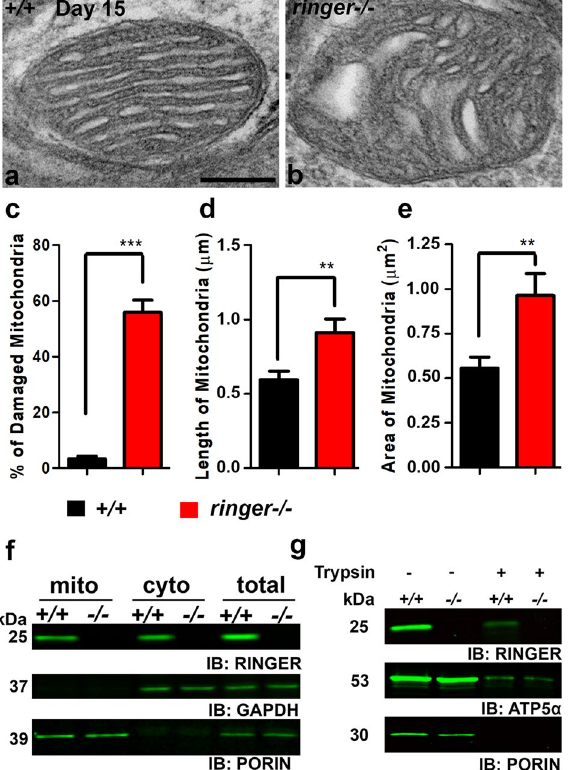
Figure 3. Ringer mutants show mitochondrial ultrastructural deficits and Ringer is detected in subcellular mitochondrial fractions. ( a , b ) Electron micrograph of mitochondria from day 15 flies shows enlarged mitochondria with disrupted cristae morphology in ringer −/− ( b ) compared to wild type ( a ). ( c - e ) Quantification of percentage of damaged mitochondria ( c ), mitochondrial length ( d ) and mitochondrial area ( e ) from ultrastructural analyses of wild type (black) and ringer −/− (red) mitochondria from mushroom body region of the adult brains. n = 6 brains per genotype. Statistics was done using unpaired student’s t test. ( c ) *** p < 0.0001, ( d ) ** p = 0.0079, ( e ) ** p = 0.0063. ( f ) Immunoblots of subcellular fractionation from wild type and ringer −/− fly heads probed for anti-Ringer, anti-Porin and anti-GAPDH in the mitochondrial (mito) and cytoplasmic (cyto) fractions and total lysates. ( g ) Immunoblots of anti-Ringer, anti-Porin and anti-ATP5α from trypsin-treated mitochondrial fractions of wild type and ringer −/− fly